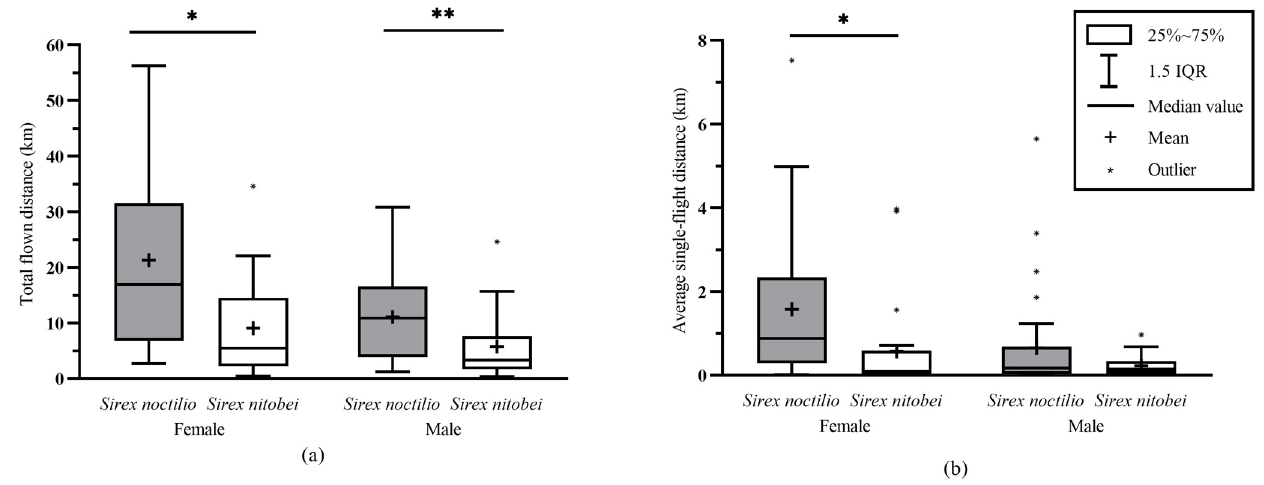
Figure 2. The comparison of the flight capacity of Sirex noctilio and Sirex nitobei (1–2 PED age). ( a ) The comparison of the total flown distance of S. noctilio and S. nitobei . ( b ) The comparison of the average single-flight distance of S. noctilio and S. nitobei . * indicates a significant difference at p = 0.05; ** indicates a significant difference at p =